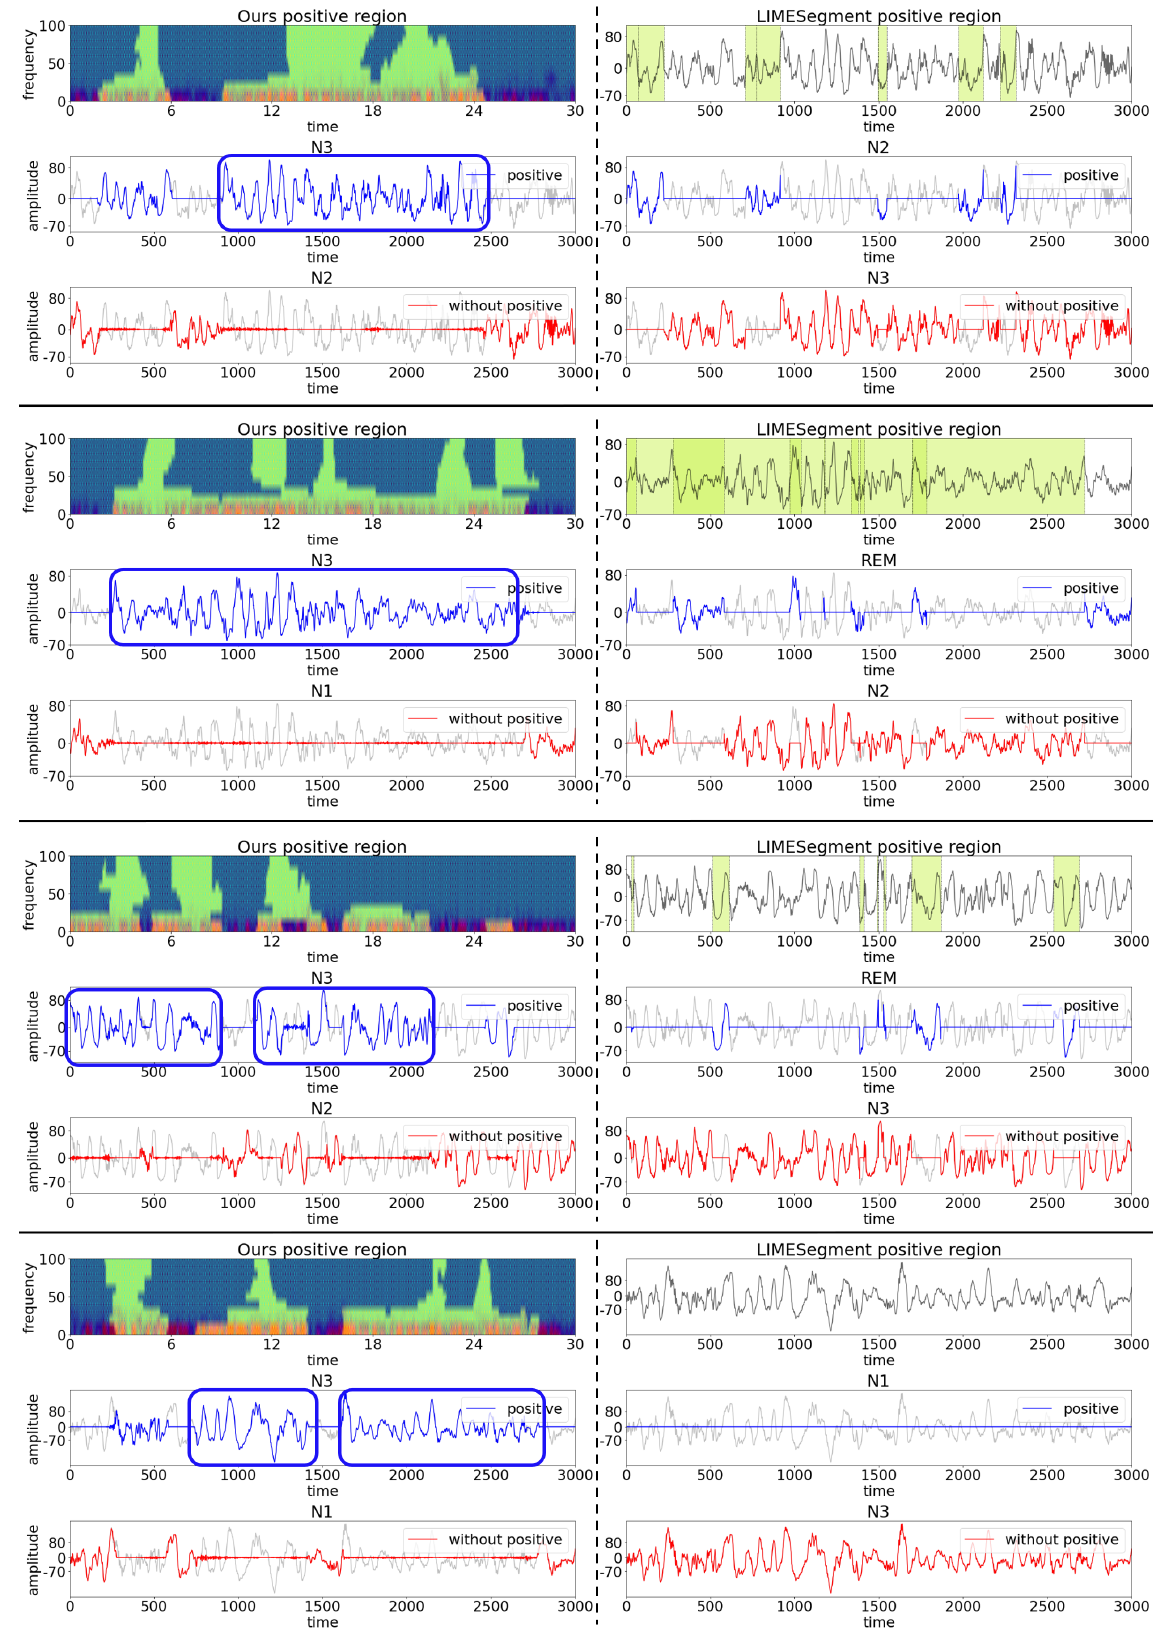
Figure A2. Additional representations obtained by ours and LIMESegment for